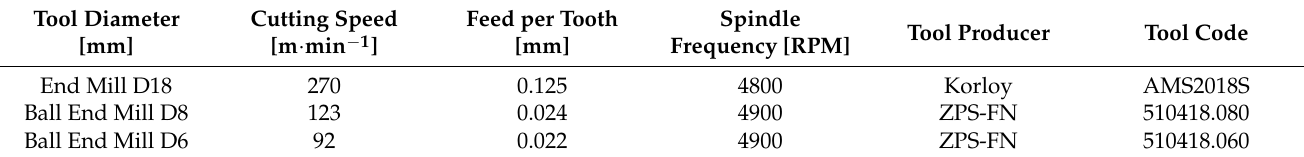
Table 2. Cutting tools used in the production with selected cutting parameters.